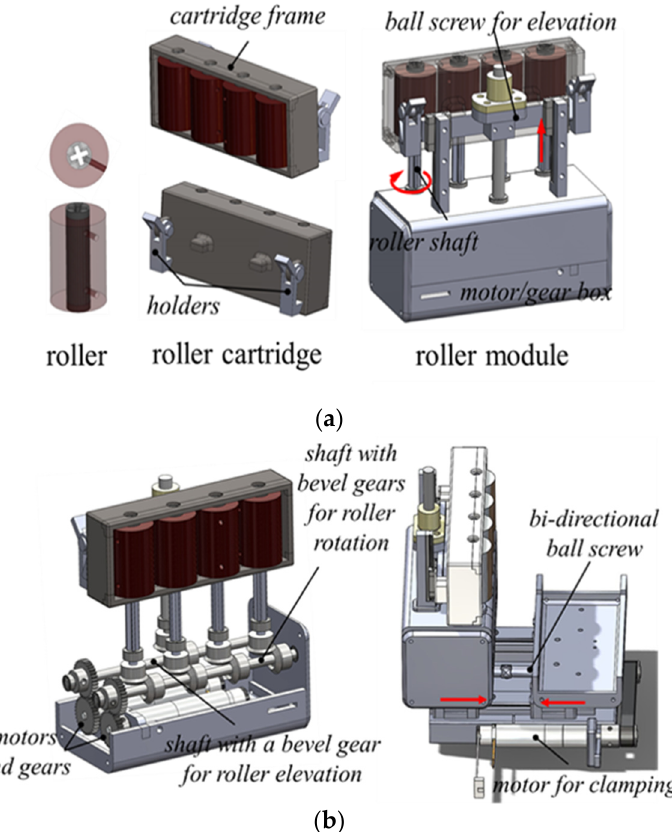
Figure 3. ( a ) Design of roller, roller cartridge, and side compartment of roller module. ( b ) Design of motor/gear box and clamping device of roller